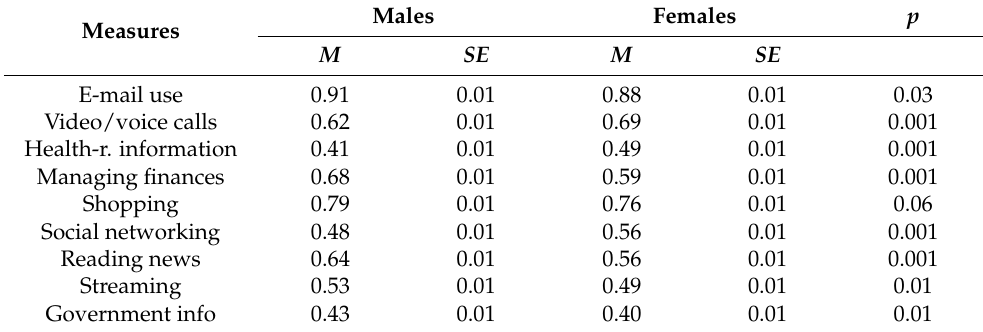
Table 4. Means and Standard Errors (Main Effect of Gender on the Type of Internet